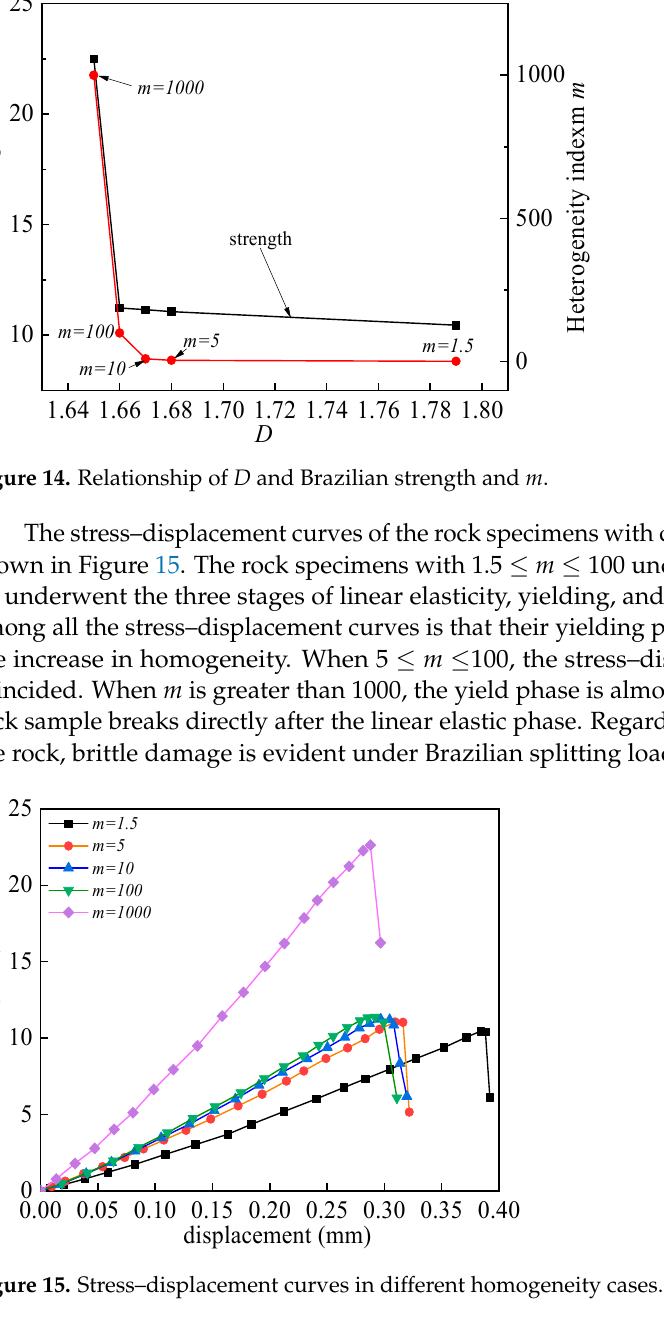
Figure 15. Stress–displacement curves in different homogeneity cases.